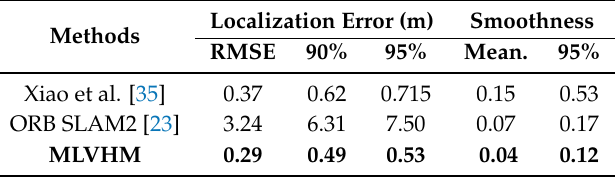
Table 3. Localization results in scenario 2.